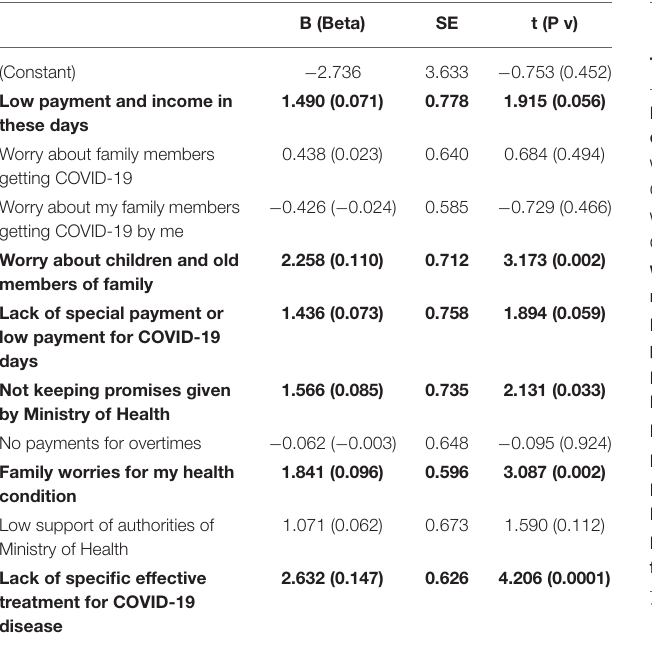
TABLE 6 | Multiple regression model for predicting burnout among the study sample.